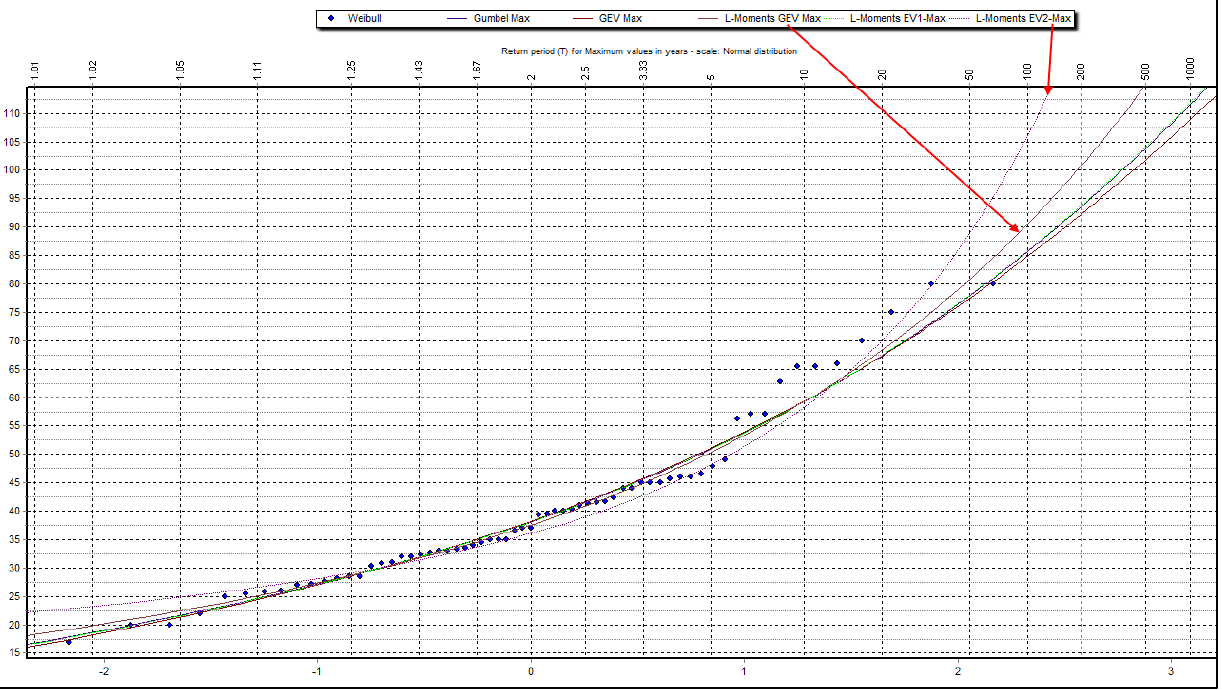
Table 3. Distributions’ performance subjected to χ 2 test.